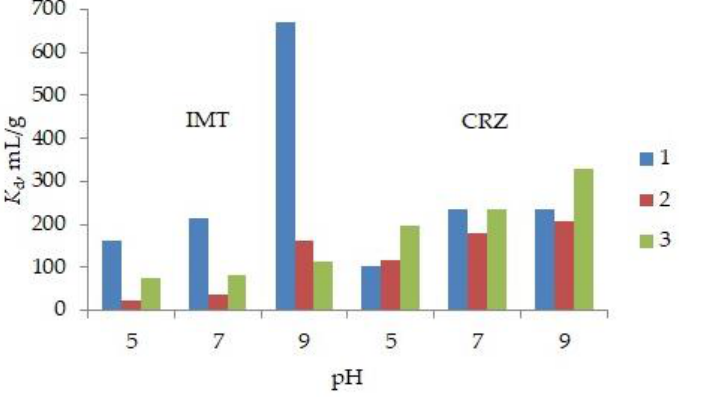
Figure 2. pH influence on IMT and CRZ sorption (1 — suspended TiO 2 , 2 — TiO 2 -GF, 3 — TiO 2 /CNT- TiO 2 GF).